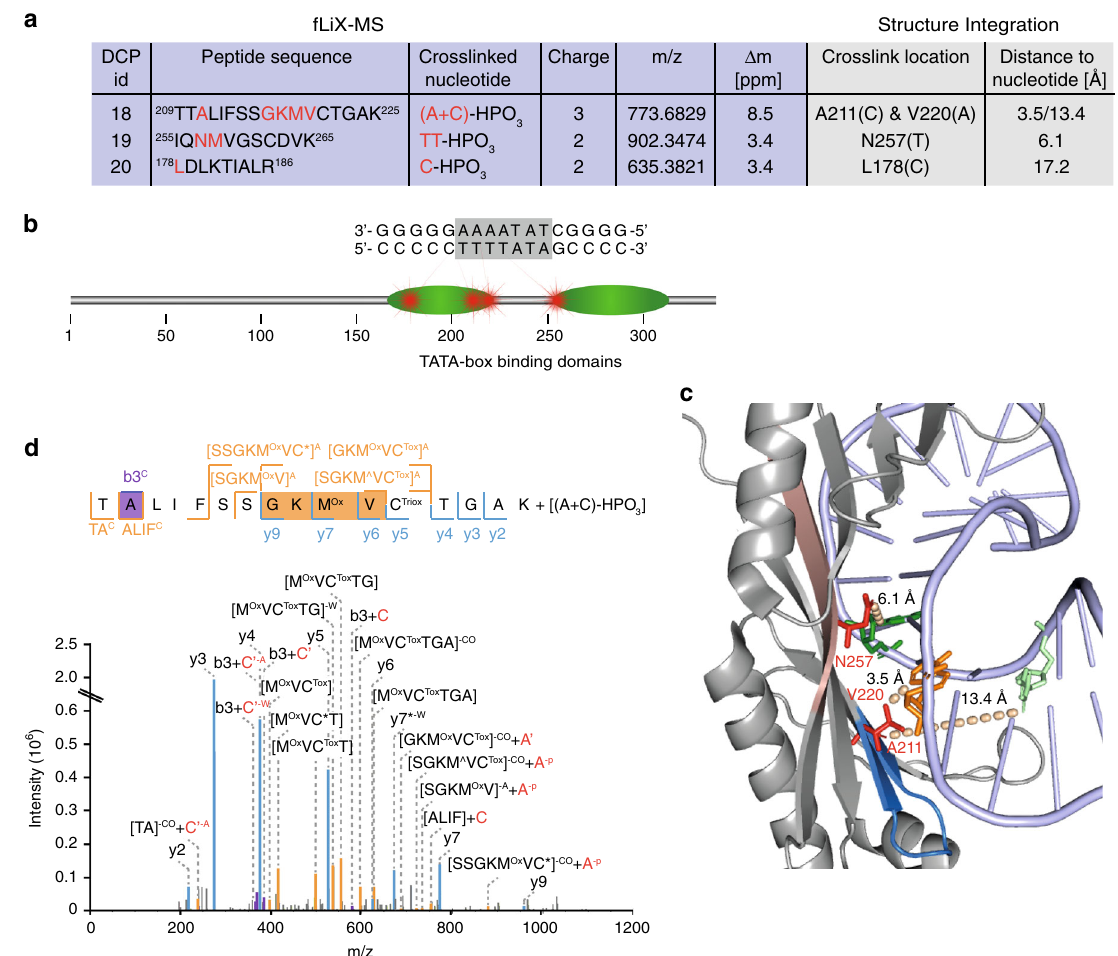
Fig. 5 Cross-linking of the TATA-box binding transcription factor TBP. a Overview of the four identi fi ed cross-links on three unique peptides. Blue background indicates information obtained from cross-linking experiments and gray background information obtained from the crystal structure (PDB ID: 1C9B 41 ). Red letters indicate possible cross-linked amino acids or cross-linked nucleotides, respectively. b Schematic view of the domain structure of TBP, the TATA box (gray shading), and surrounding nucleotides, as well as the cross-links. c Crystal structure of TBP bound to an extended Adml promoter (PDB ID: 1C9B 41 ). Location of the cross-link of N257 to one of the two thymidines (green) and of the cross-links of amino acid V220 to deoxyadenosine (orange) and A211 to deoxycytidine (light green). Cross-linked amino acids are depicted in red, the peptide 255 IQNMVGSCDVK 265 in light red, and the peptide 209 TTALIFSSGKMVCTGAK 225 in blue. Dashed lines represent the distance of amino acid to nucleotide and distance is shown above the line. d MS2 ion series and spectra of the cross-linked TTALIFSSGKMVCTGAK peptide. Abbreviations in the MS2 spectra and MS2 ion series: caret: neutral loss of CH 4 SO, Tox: trioxidated cysteine (cysteic acid). Other abbreviations as in Fig.